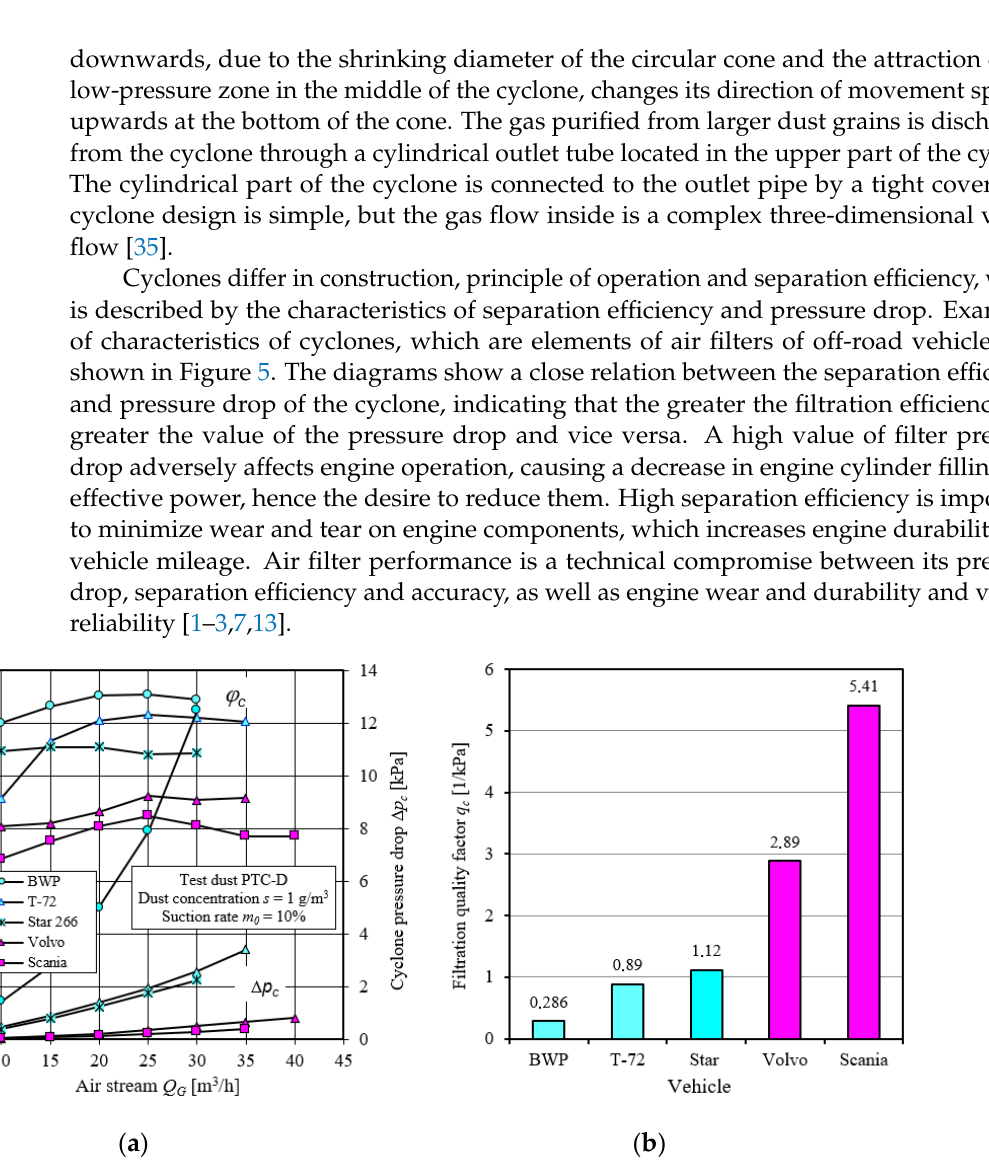
Figure 5. Filtration properties of cyclones as elements of off-road vehicle air filters: ( a ) characteristics of separation efficiency φ c = f ( Q G ) and pressure drop Δ p c = f ( Q G ); ( b ) filtration quality factor.